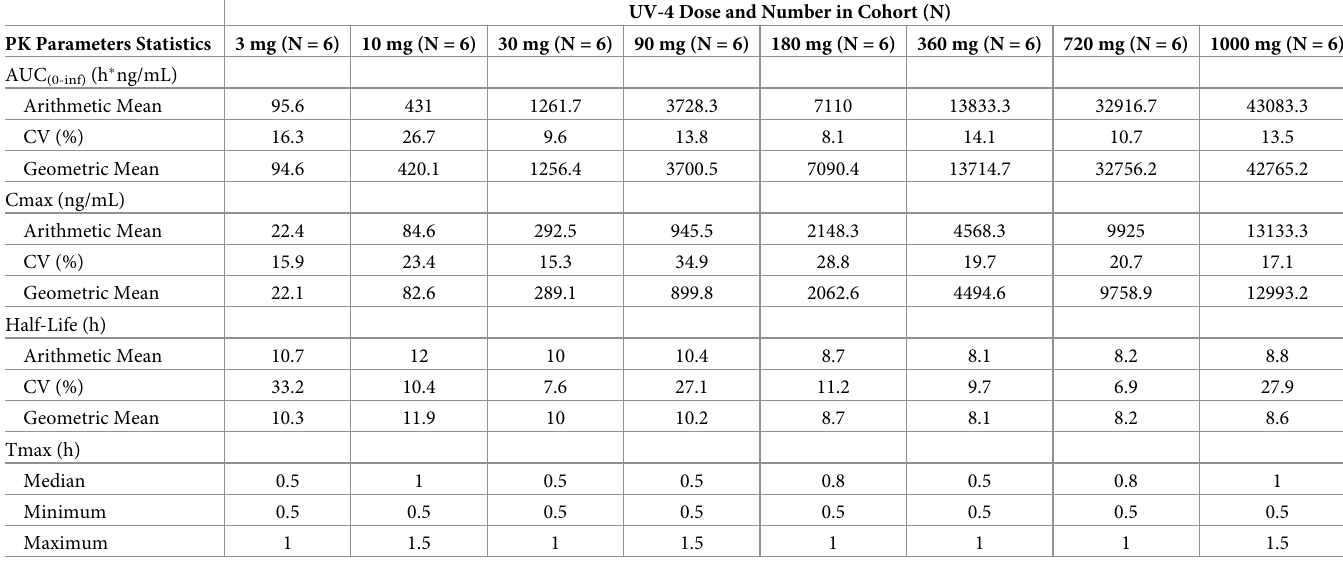
Table 5. Summary of Key UV-4 Pharmacokinetic Parameters.